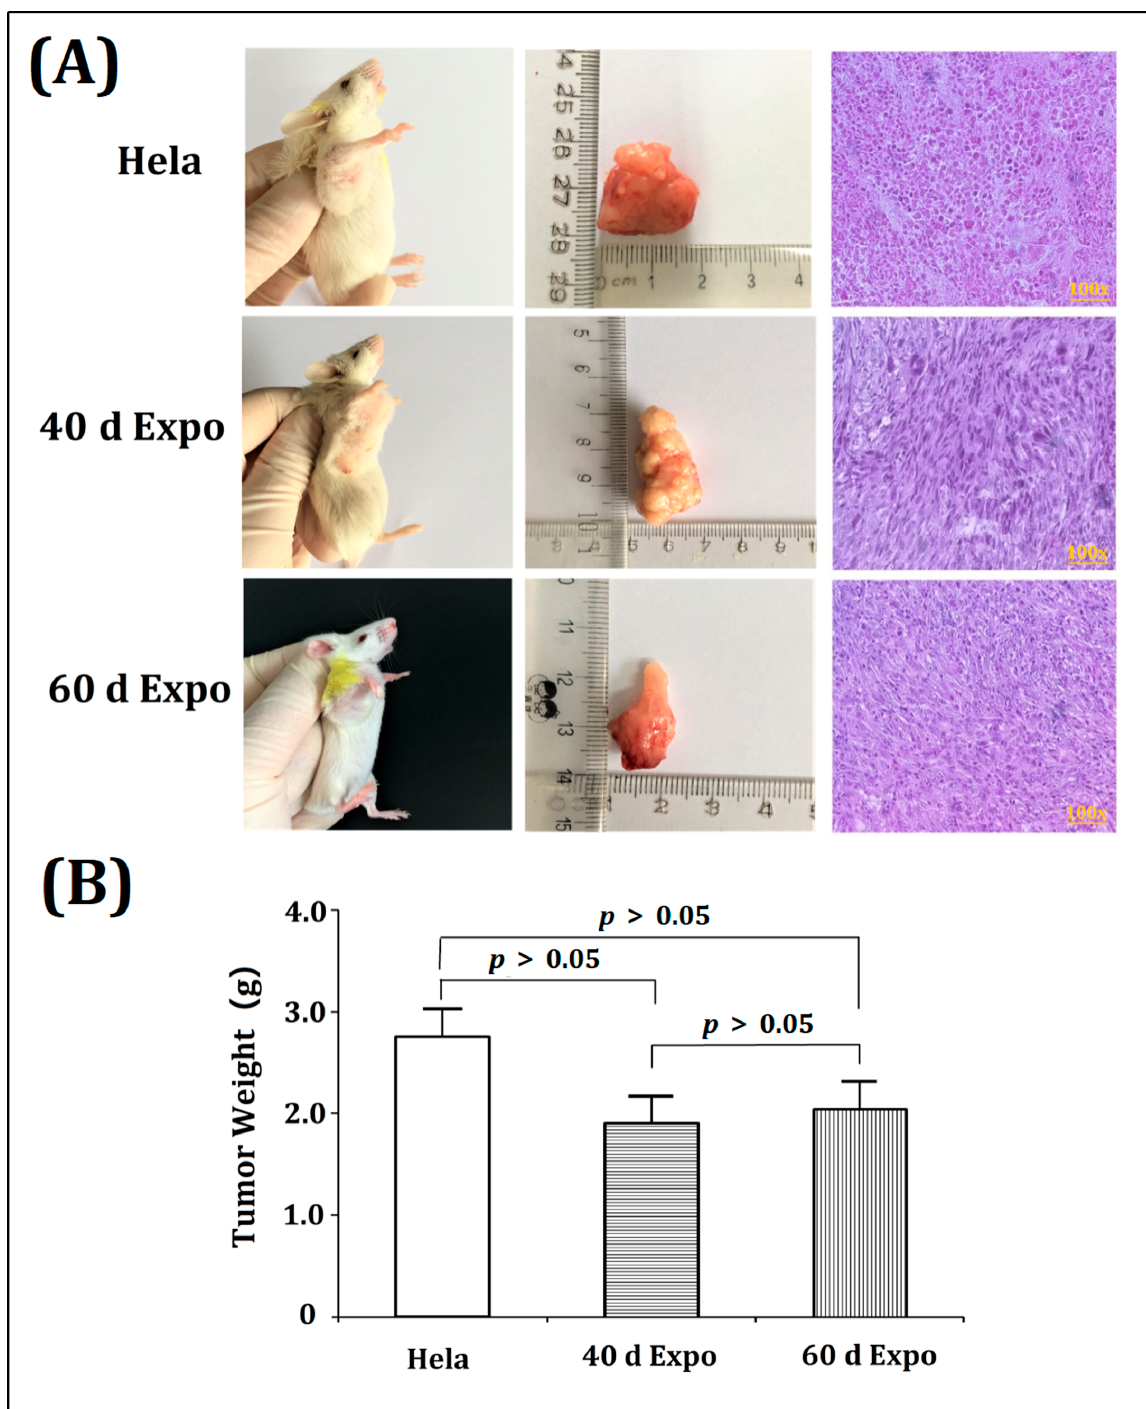
Figure 4. Significant tumorigenicity induced by 1800 MHz EMR in Balb/c-3T3 cells. Visible tumors were observed in SCID mice transplanted with 40-day expo and 60-day expo Balb/c-3T3 cells. The tumors were obtained and subjected to HE staining. ( A ) SCID mice were transplanted with HeLa, 40-day expo, and 60-day expo Balb/c-3T3 cells. The tumors were sectioned and subjected to HE staining. ( B ) Histogram showing the mean tumor weight obtained from SCID mice injected with HeLa, 40-day expo, and 60-day expo Balb/c-3T3